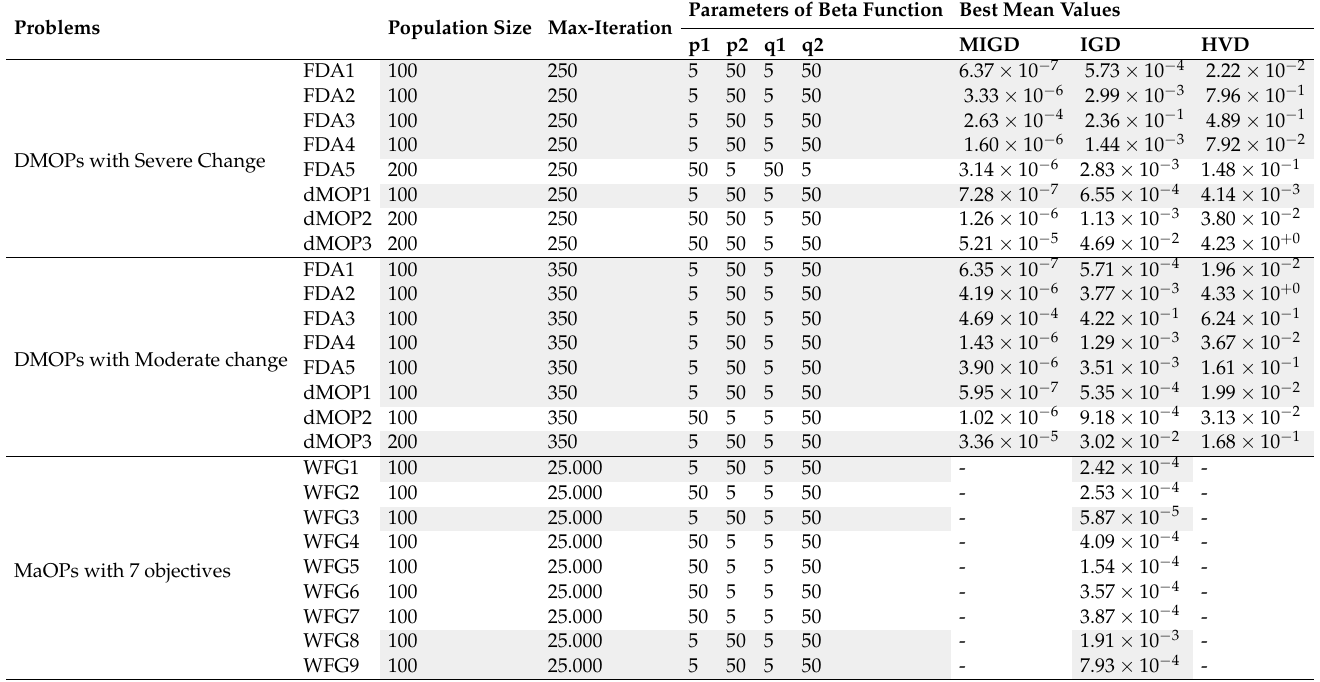
Table 7. Best Experimental Design using Taguchi Method for MIGD, IGD, HVD Metric for DMOPs (FDA, dMOP) with Severe and Moderate Dynamic Changes and MaOPs with 7 Objectives (WFG). Parameters of Beta Function Best Mean Values